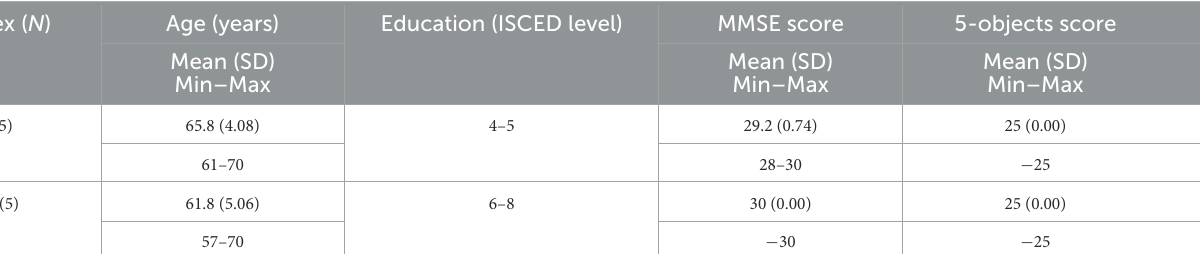
TABLE 2 Participants’ demographics and cognitive tests